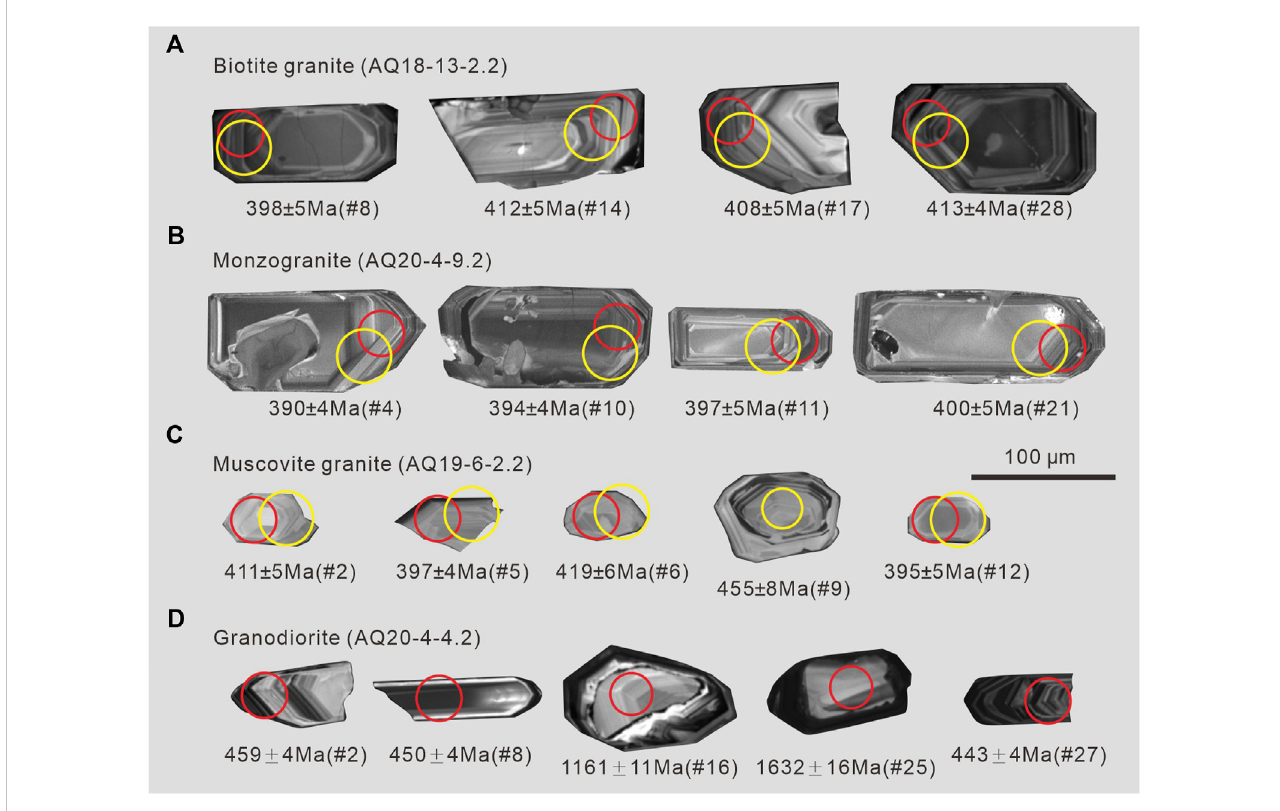
FIGURE 5 (A – D) Cathodoluminescence(CL)imagesofinvestigatedgraniticzircons.TheredandyellowcirclesindicatethelocationsofU-PbdatingandHfisotopic